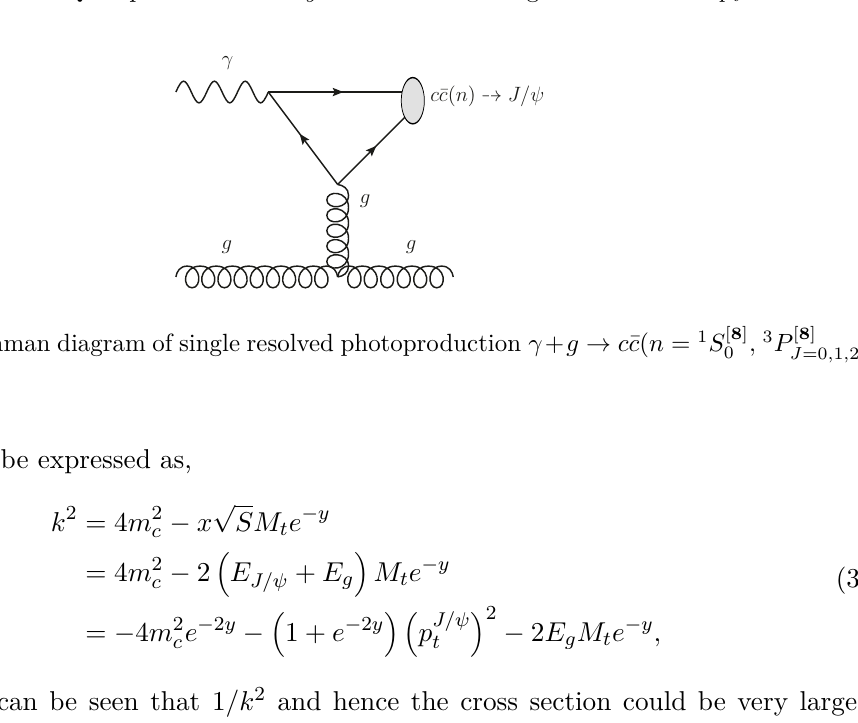
Figure 5 . Kinematic distributions for the resolved photoproduction of J/ψ at the ILC ( 500 GeV ). The y and cos θ distributions are plotted under the cut p t > 5 GeV . All the distributions are plotted for the NRQCD predictions and y curves use same legends as those of p t .